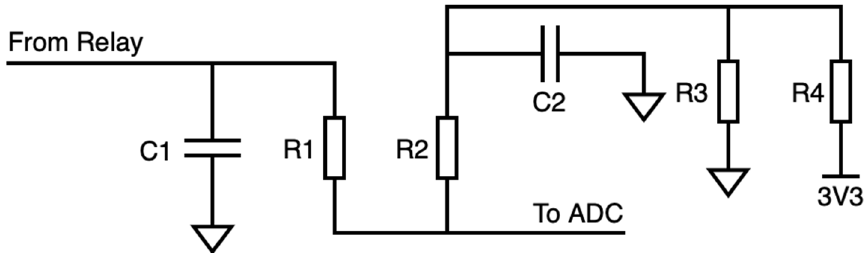
Figure 7. Conceptual schematic for the current metering subsystem.